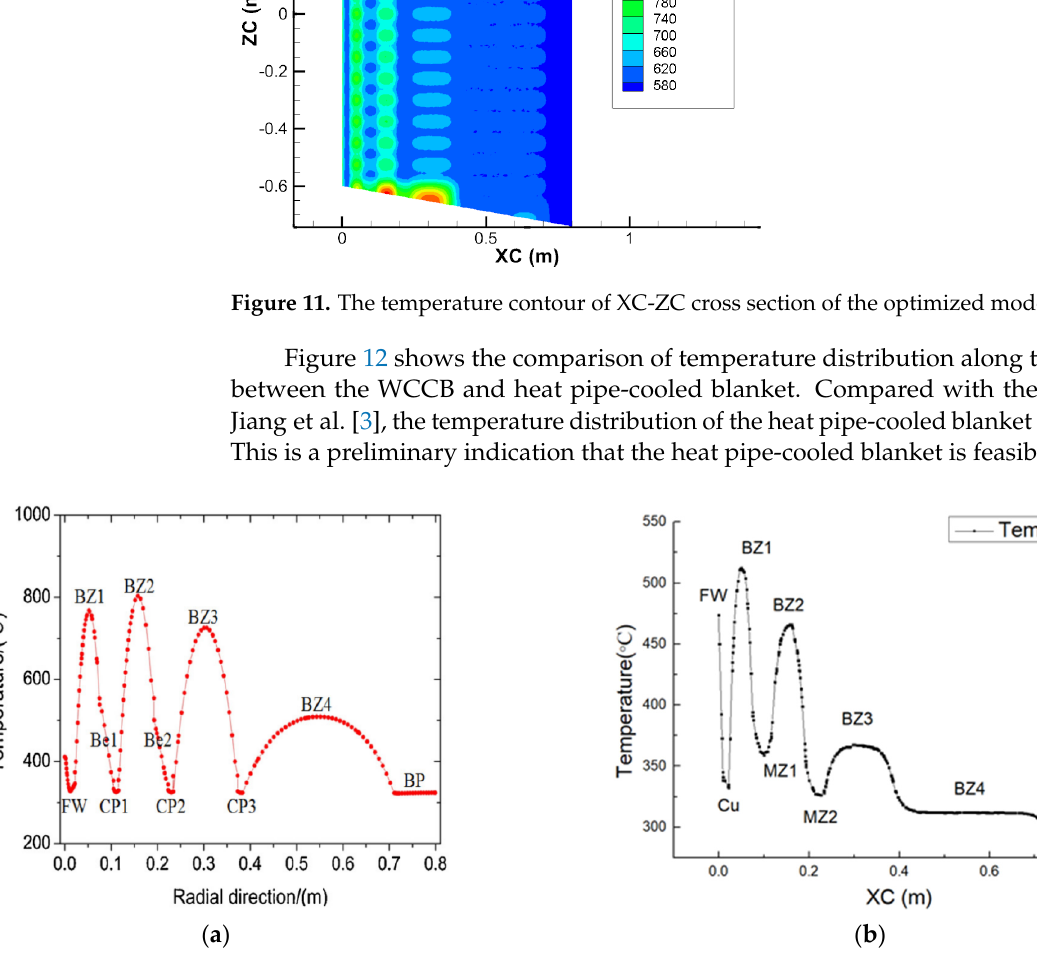
Figure 12. The maximum temperature distribution on the XC direction: ( a ) The temperature distribution of the WCCB. (CFD results of Jiang et al. [3]) Reprinted with permission from [3]. Copyright 2016 Elsevier; ( b ) The temperature distribution of the optimized blanket.